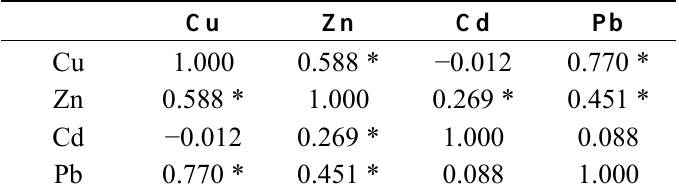
Table 5. Correlation Analysis of Cu, Zn, Cd, and Pb Concentrations based on the combined data of soil and